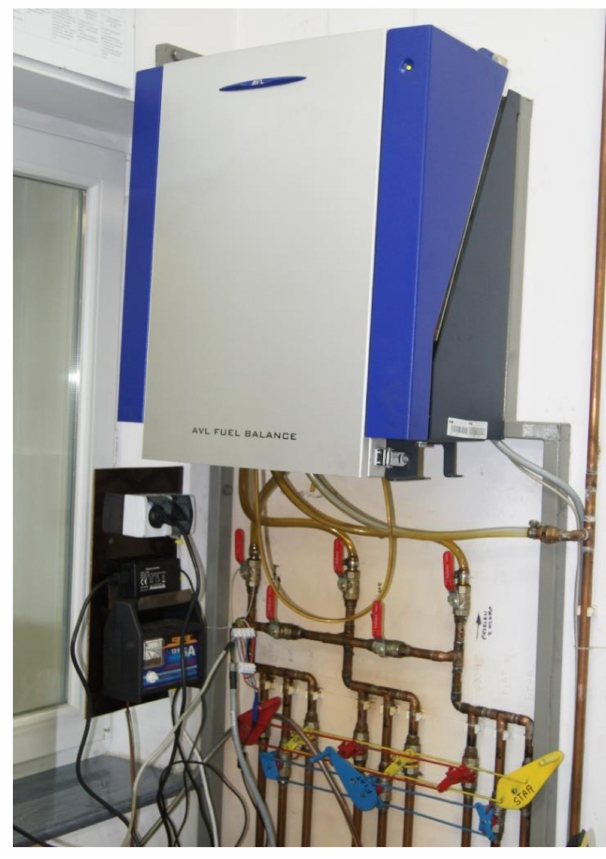
Figure 3. AVL Fuel Balance 4210 mass dynamic fuel